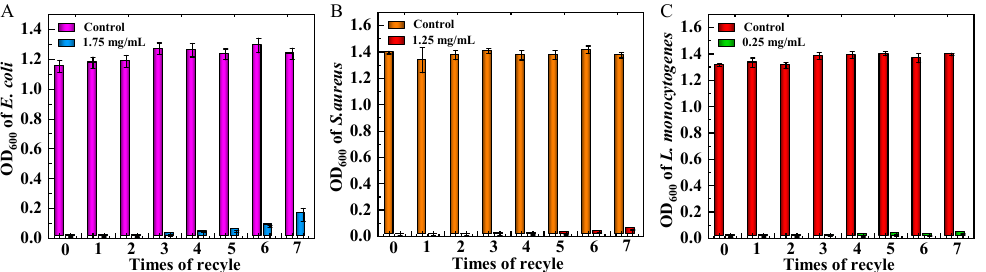
Figure 7. Recyclable antibacterial activity of GS-MGO against E. coli ( A ), S. aureus ( B ) , and L. monocytogenes ( C ) with di ff erent concentrations.